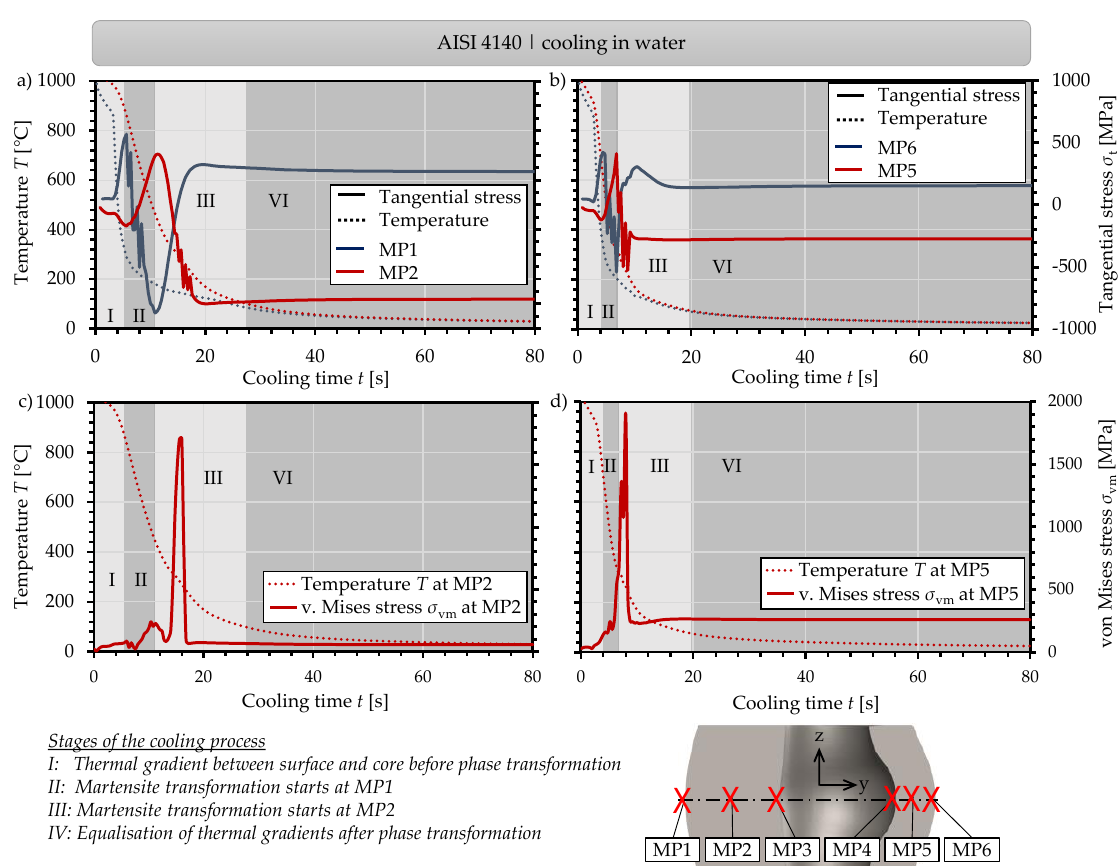
Figure 10. Temporal development of the temperature and tangential stresses on the thick-walled side at MP1 and MP2 ( a ), and on the thin-walled side at MP5 and MP6 ( b ) during the cooling of AISI 4140 in water, supported by the temporal development of the von Mises stress at MP2 ( c ) and MP5 ( d